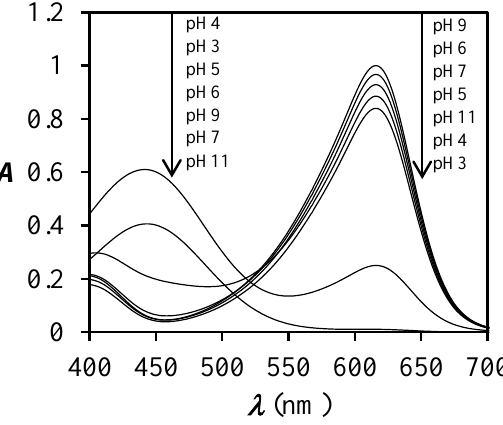
Figure 8. Absorption spectra of BCG dye in buffer solutions with different pH values ranging from pH 3 to 11 (pH 3, 4, 5, 6, 7, 9, and 11).